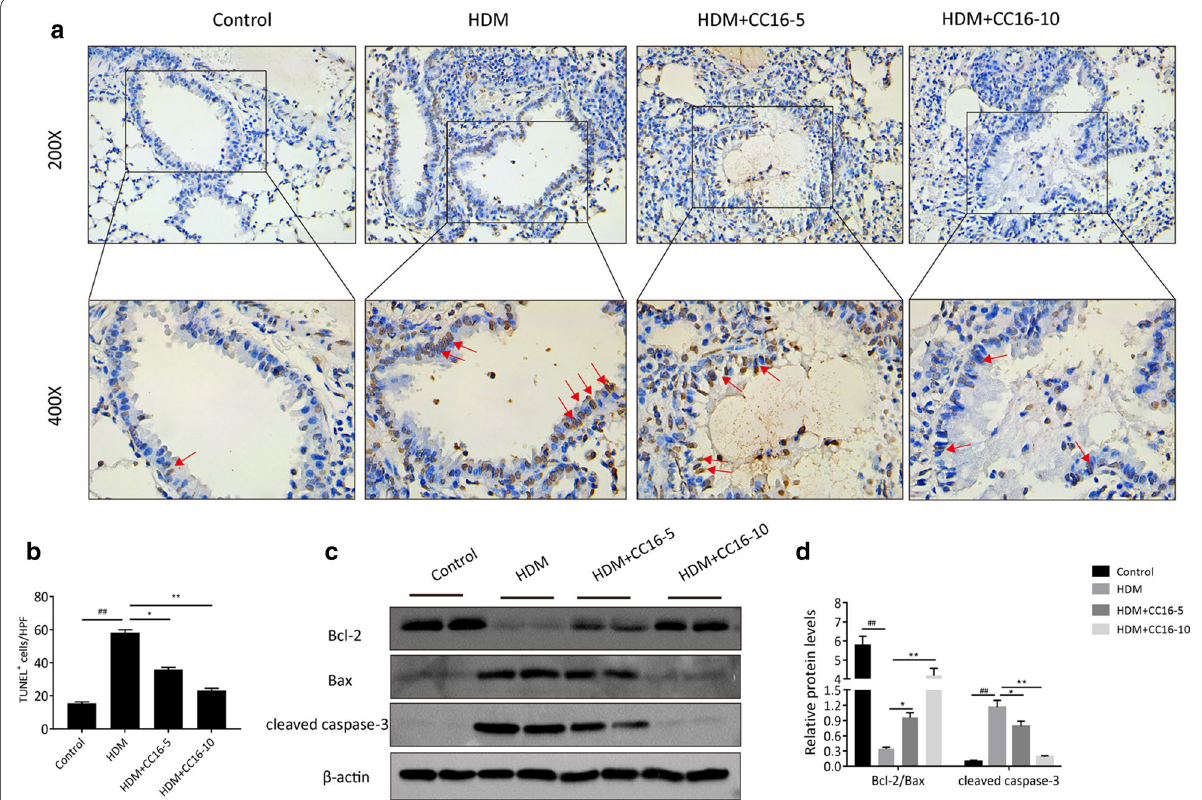
Fig. 2 CC16 suppresses HDM-induced airway epithelial apoptosis in mice. a Representative staining for TUNEL images from airway epithelial tissues of each group (magnification at 200 and 400). b Quantitative assessment of the percentage of TUNEL-positive cells in 5 random areas for × × each section. Red arrows indicated apoptotic airway epithelial cells. c Representative immunoblotting images of Bcl-2, Bax and cleaved caspase-3 expressions in lung tissues from each group. d Relative expression levels of above proteins was shown as bar graphs. Data are expressed as means SEM. ## p < 0.01 vs. Control group; *p < 0.05 vs. HDM group; **p < 0.01 vs. HDM ±